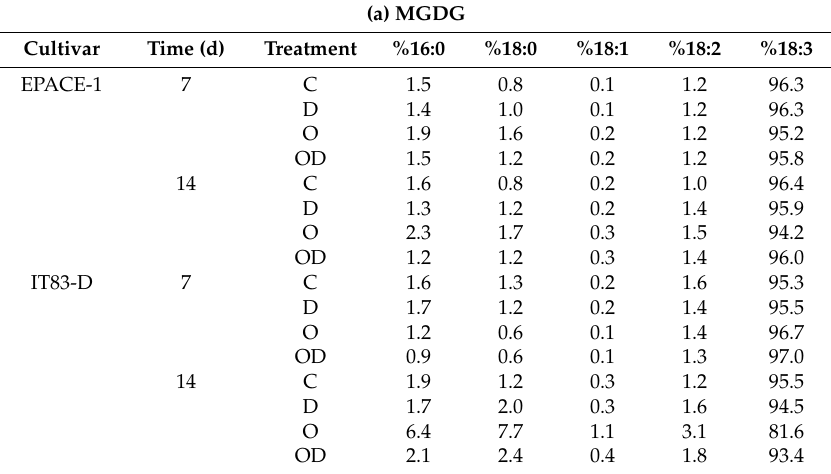
Figure A1. Detection of hydrogen peroxide using DAB staining in Vigna unguiculata leaves exposed to the following treatments: Control (C), Drought (D), Ozone (O), Ozone + Drought (OD). Leaf discs were collected and stained after 14 days of treatment. Pictures are representative of three independent biological replicates. No specific staining was observed in control leaves treated with ascorbic acid (data not shown). DAB: 3,3 ′ -diaminobenzidine. Bar = 250 µm. Table A1. ( a ) MGDG and ( b ) DGDG fatty acid composition in the leaves of Vigna unguiculata plants subjected to the following treatments: Control (C), Drought (D), Ozone (O), Ozone + Drought (OD). Values are expressed as percentages of the total fatty acid content in a given lipid class, averaged from three independent biological replicates. Data in bold belong to subsets that only partially merge the core data set, data in bold on a grey background belong to strictly separate subsets (one-way ANOVA and Tukey post-hoc tests, α = 0.05). MGDG, monogalactosyl-diacylglycerol; DGDG, digalactosyl-diacylglycerol; 16:0, hexadecanoic acid; 18:0, octadecanoic acid; 18:1, 9-octadecenoic acid; 18:2, 9,12-octadecadienoic acid; 18:3, 9,12,15-octadecatrienoic